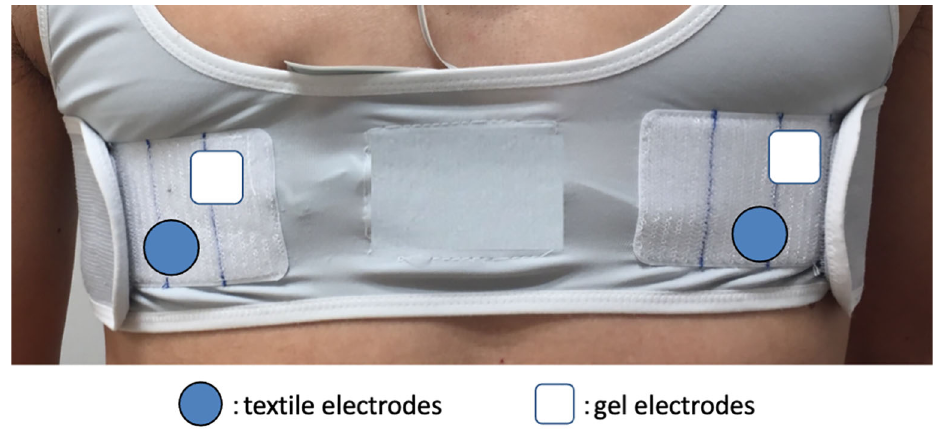
Figure 1. Simultaneous positioning of textile and gel electrodes. Bipolar electrodes for CC5lead were positioned to avoid interference between textile and gel